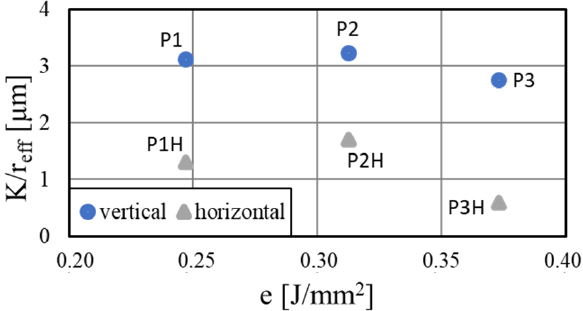
Figure 14. Performance of the porous wicks for different printing parameters and orientations cal- culated by rate-of-rise experiment.